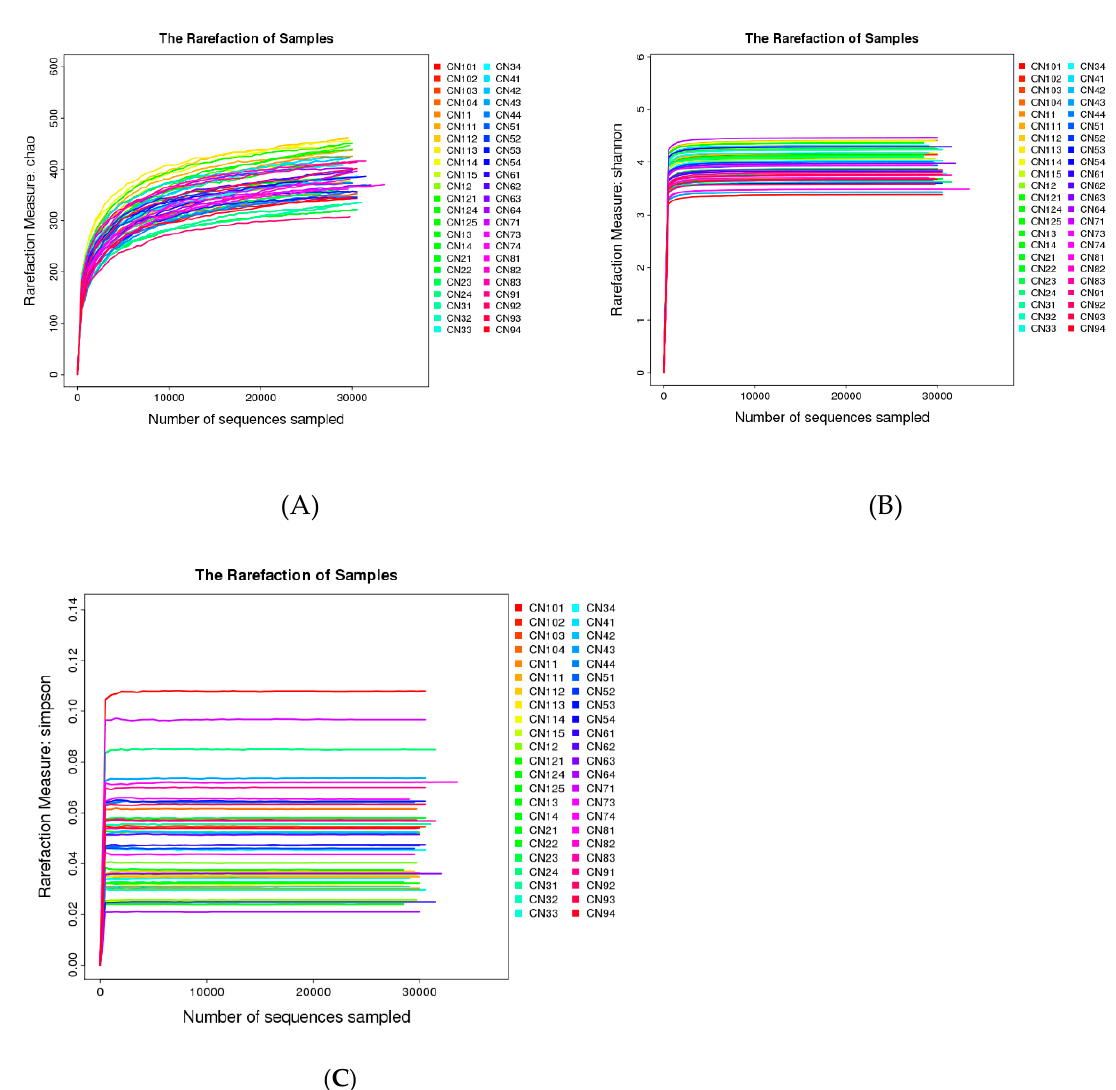
Figure 8. Rarefaction analysis curve based on alpha diversity. ( A ) Chao index rarefaction curve; ( B ) Shannon index rarefaction curve; ( C ) Simpson index rarefaction curve.